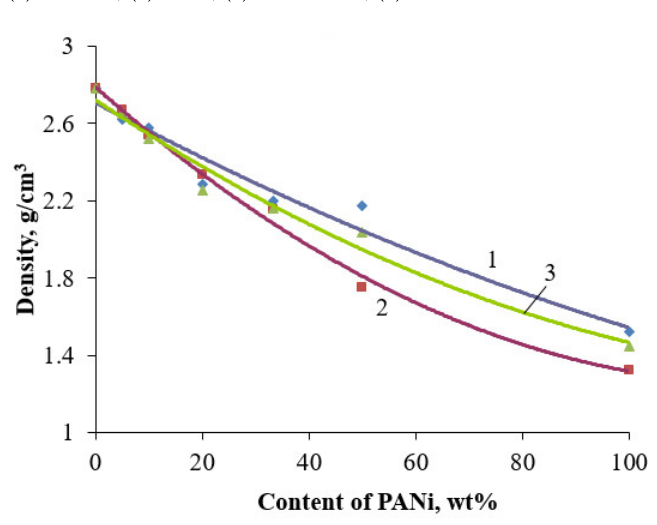
Figure 15. Dependence of the density of core/shell pigments on the content of PANi doped with various acids (core/shell pigment based on talc). Doping acid: (1)—H 2 SO 4 ; (2)—HCl; (3)—H 3 PO 4 . It is clear that the growth of PANi content in core/shell pigment corresponds with density reduction. The reason for that is the lower density of PANi over the starting filler.